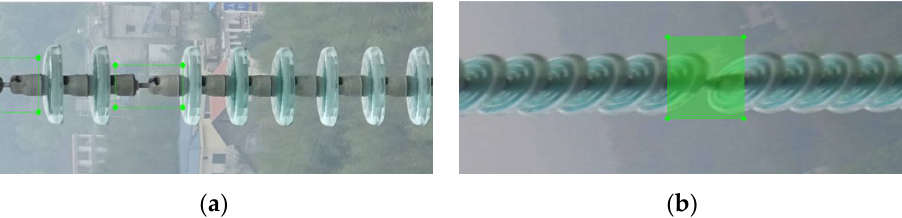
Figure 12. Object labeling of insulator defective area: ( a ) Horizontal object detection result labeling; ( b ) Rotated object detection result labeling.